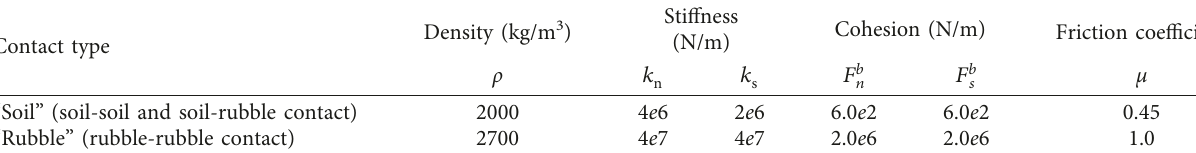
Table 3: Mesoscopic parameters of